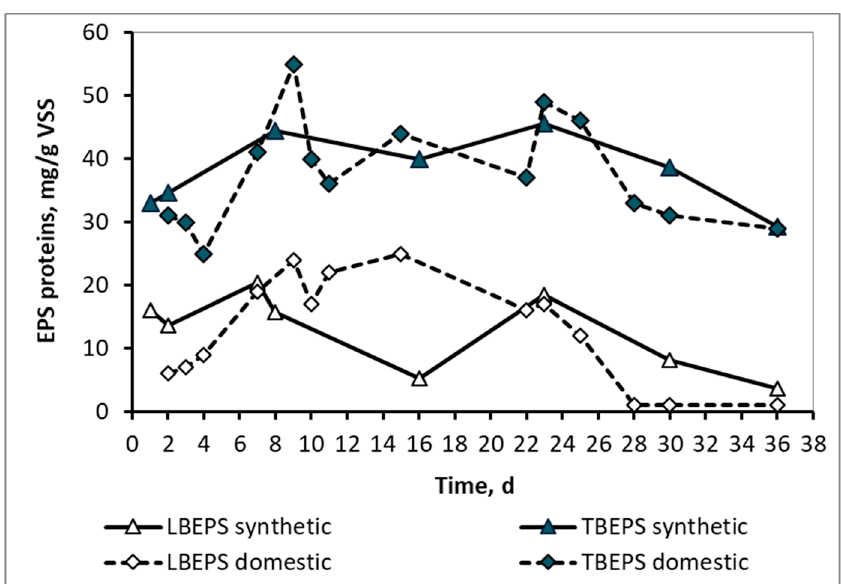
Figure 5. Loosely bound EPS (LBEPS) and tightly bound EPS (TBEPS) concentrations in the form of proteins for the mixed liquor of synthetic and domestic wastewater.